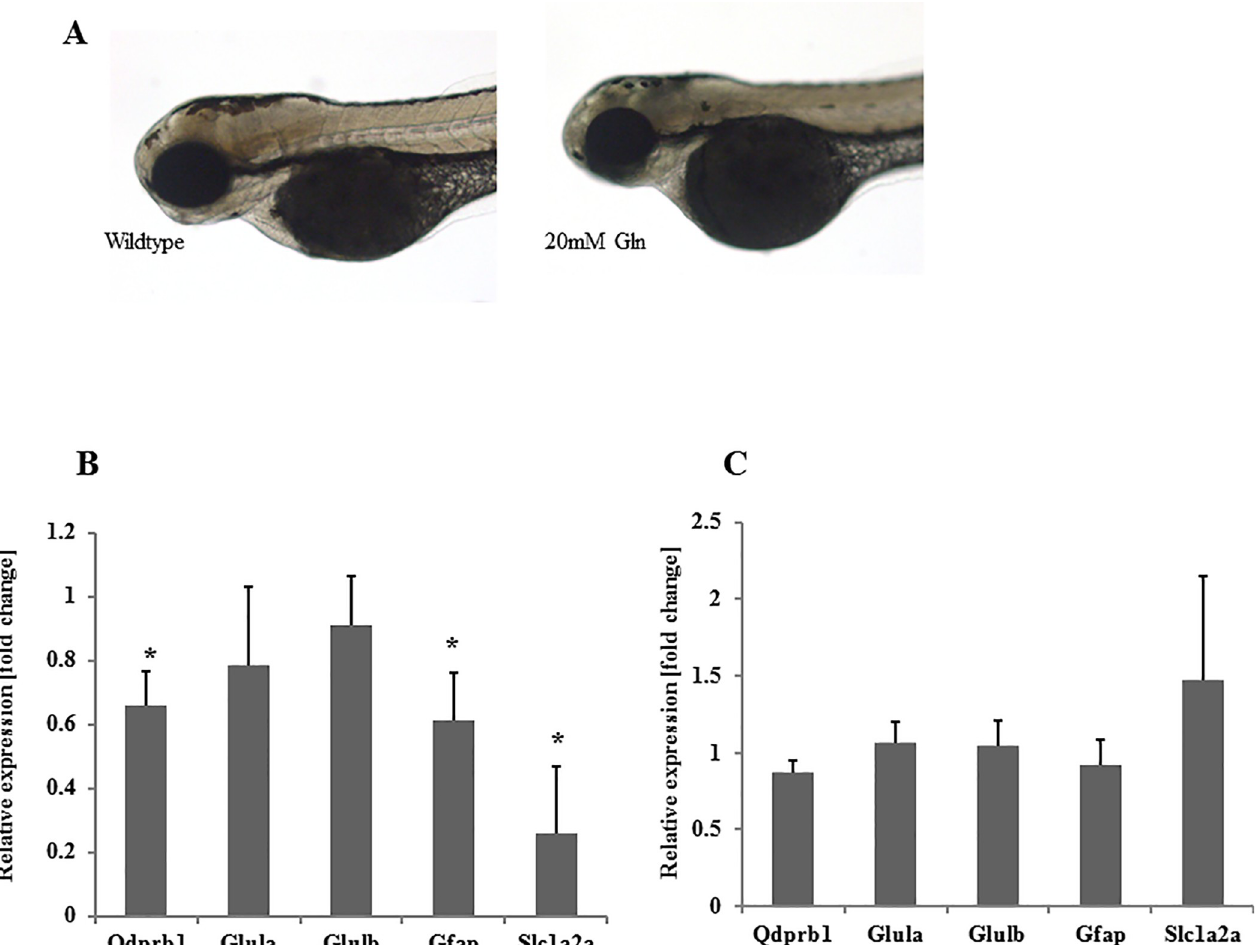
Fig 6. Glutamine exposure partially mimics qdprb1 knockdown. (A) Lateral views with anterior to the left. Zebrafish exposed to 20 mM glutamine from sphere stage till 72 hpf display smaller heads and eyes. (B) RT-qPCR analysis zebrafish early exposed to glutamine (20 mM) shows reduced expression of qdprb1 , gfap , and slc1a2a . (C) Late exposure to glutamine starting at 48 hpf does not affect the expression of these